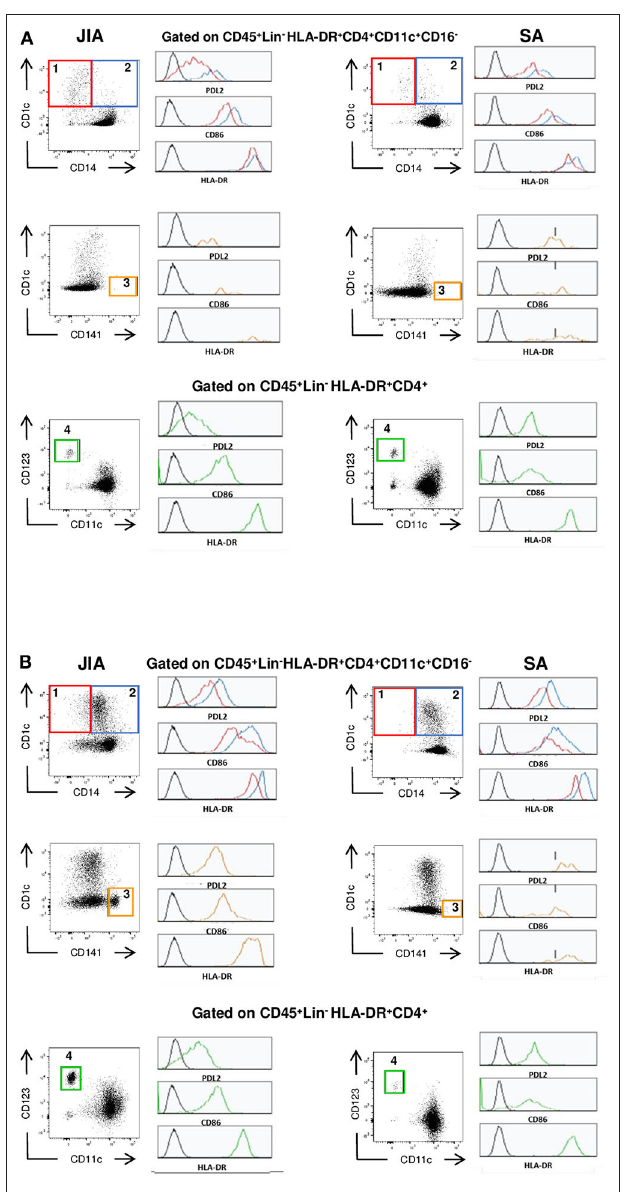
FIGURE 3 | Stratification of patients with JIA and SA based on monocyte proportion and all cell counts. (A) Heatmap of monocyte proportion and all cell counts in peripheral blood (PB) and synovial fluid (SF) by multi-parametric flow cytometry. In the color scale, yellow indicates relative higher and blue relative lower cell numbers/proportion. Gray data are undetermined. The dendrogram shows the results of the non-supervised hierarchical clustering analysis; in the heatmap: rows, cell subsets; and columns, individual patients with JIA (gray, n = 15) and SA (black, n = 14). (B) Heatmap showing markers that were significantly differentially expressed between patients with SA and JIA. The dendrogram shows the results of the non-supervised hierarchical clustering analysis using an FDR cut-off of 5%. (C) Direct comparison of the 5 differentially expressed cells counts in synovial fluid (SF) and non-classical monocyte proportion in peripheral blood (PB) from JIA (white, n = 15) and SA (gray, n = 14) patients. Data are represented for all patients and horizontal bars are the mean ± SEM. * p < 0.05; ** p < 0.01; *** p < 0.001; **** p < 0.0001 (two-sided t or Mann–Whitney test, according to data distribution after FDR